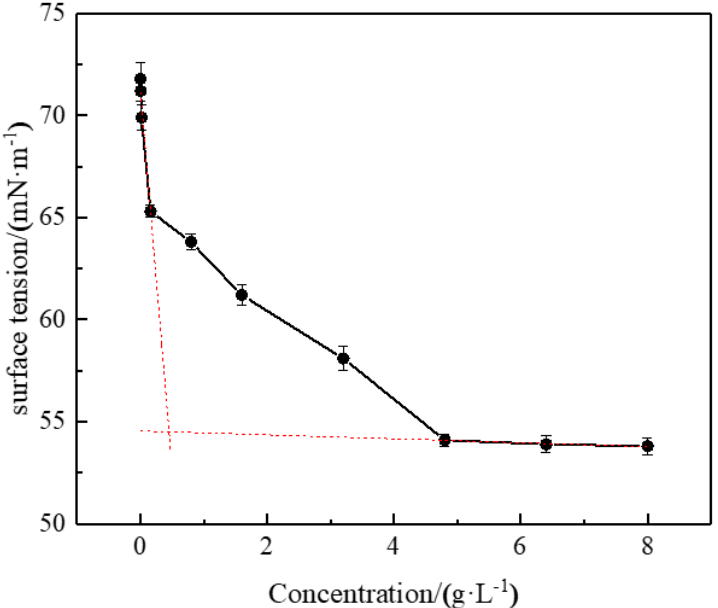
Figure 7. The surface tension of the dispersant solution with different concentrations.